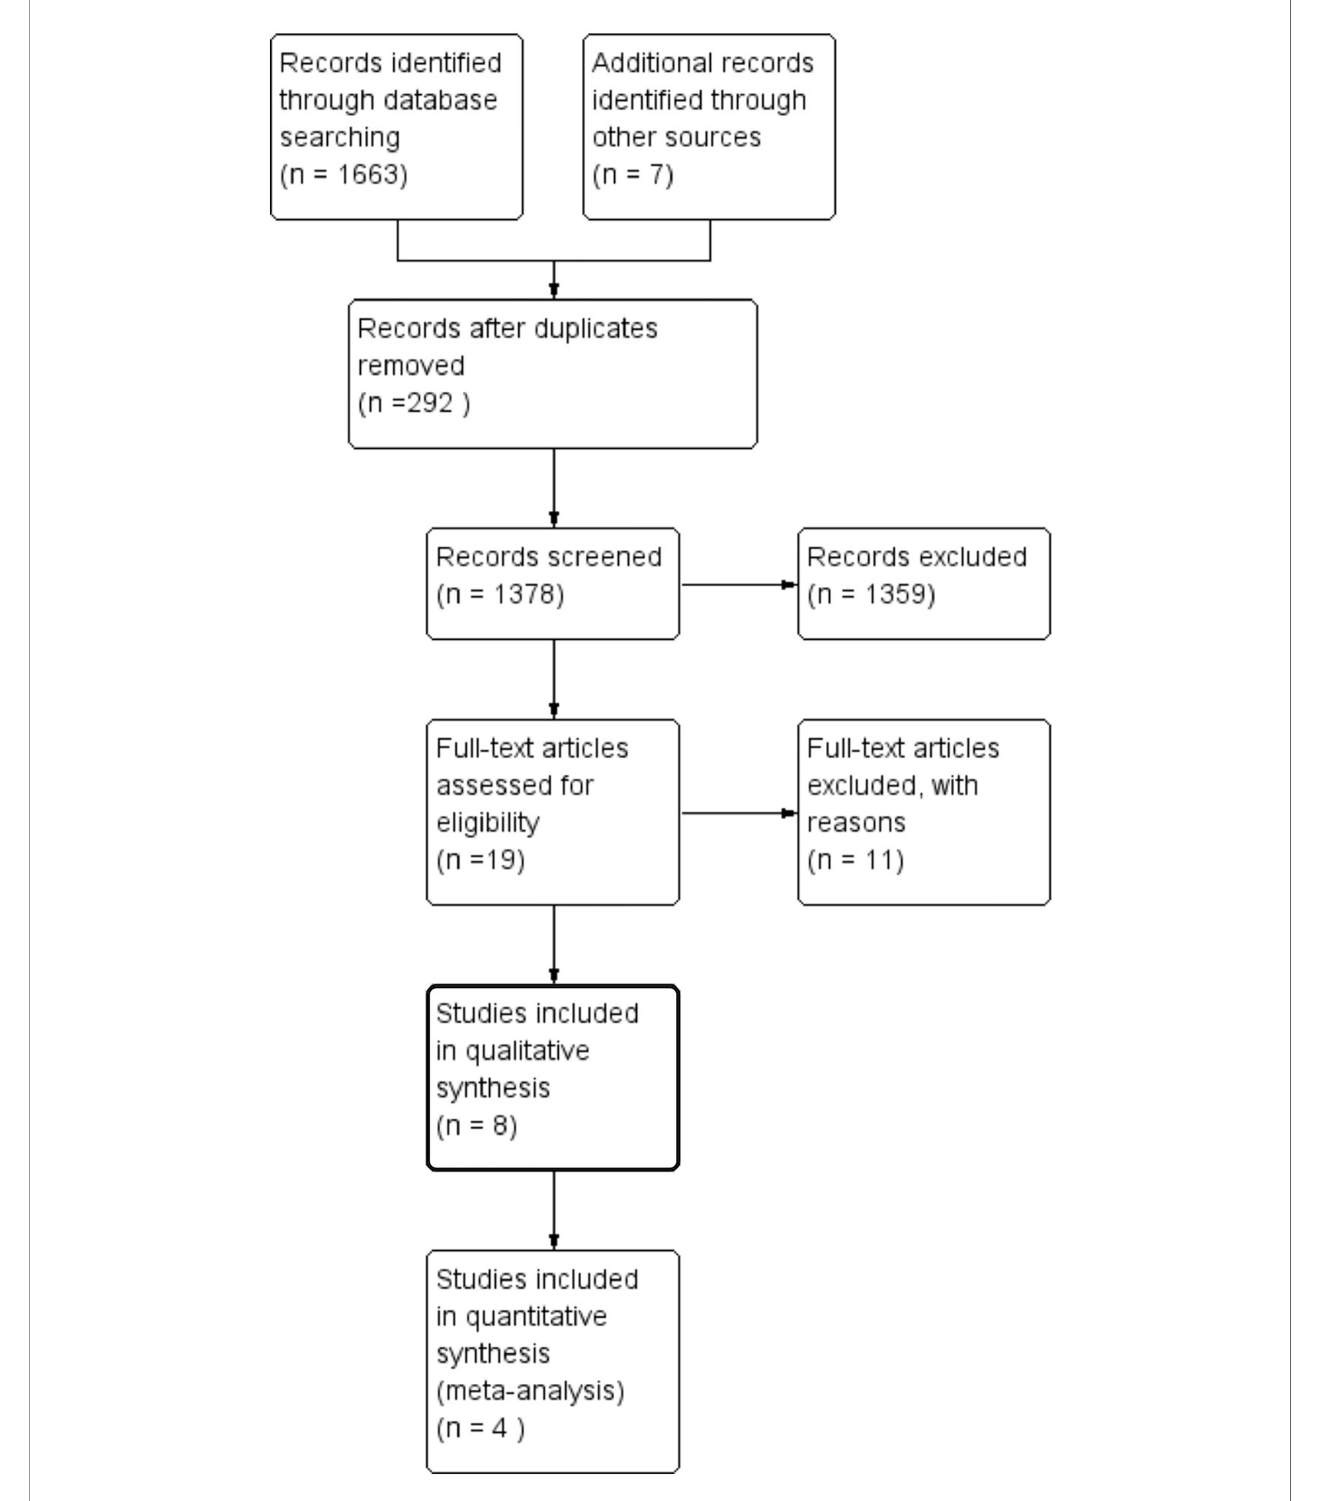
FIGURE 1 | Study selection fl ow